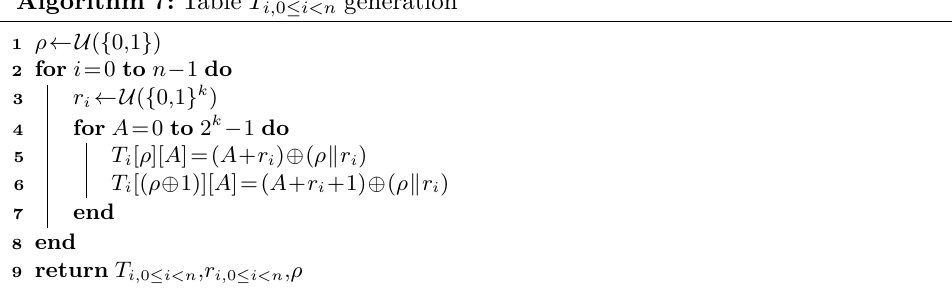
Algorithm 7: Table T i, 0 ≤ i<n